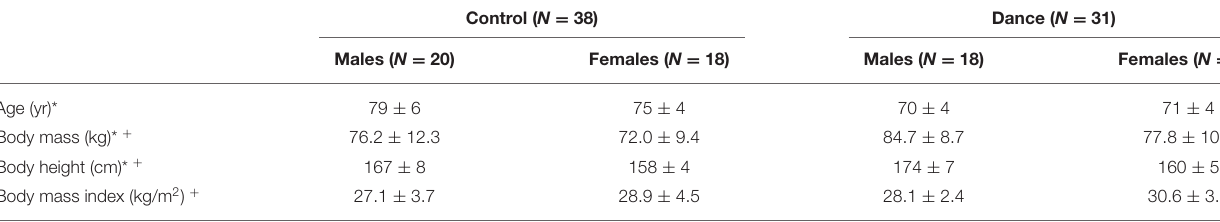
TABLE 1 | Anthropometric data for the non-dancer (control) and dancer (dance) groups (means ± SD).